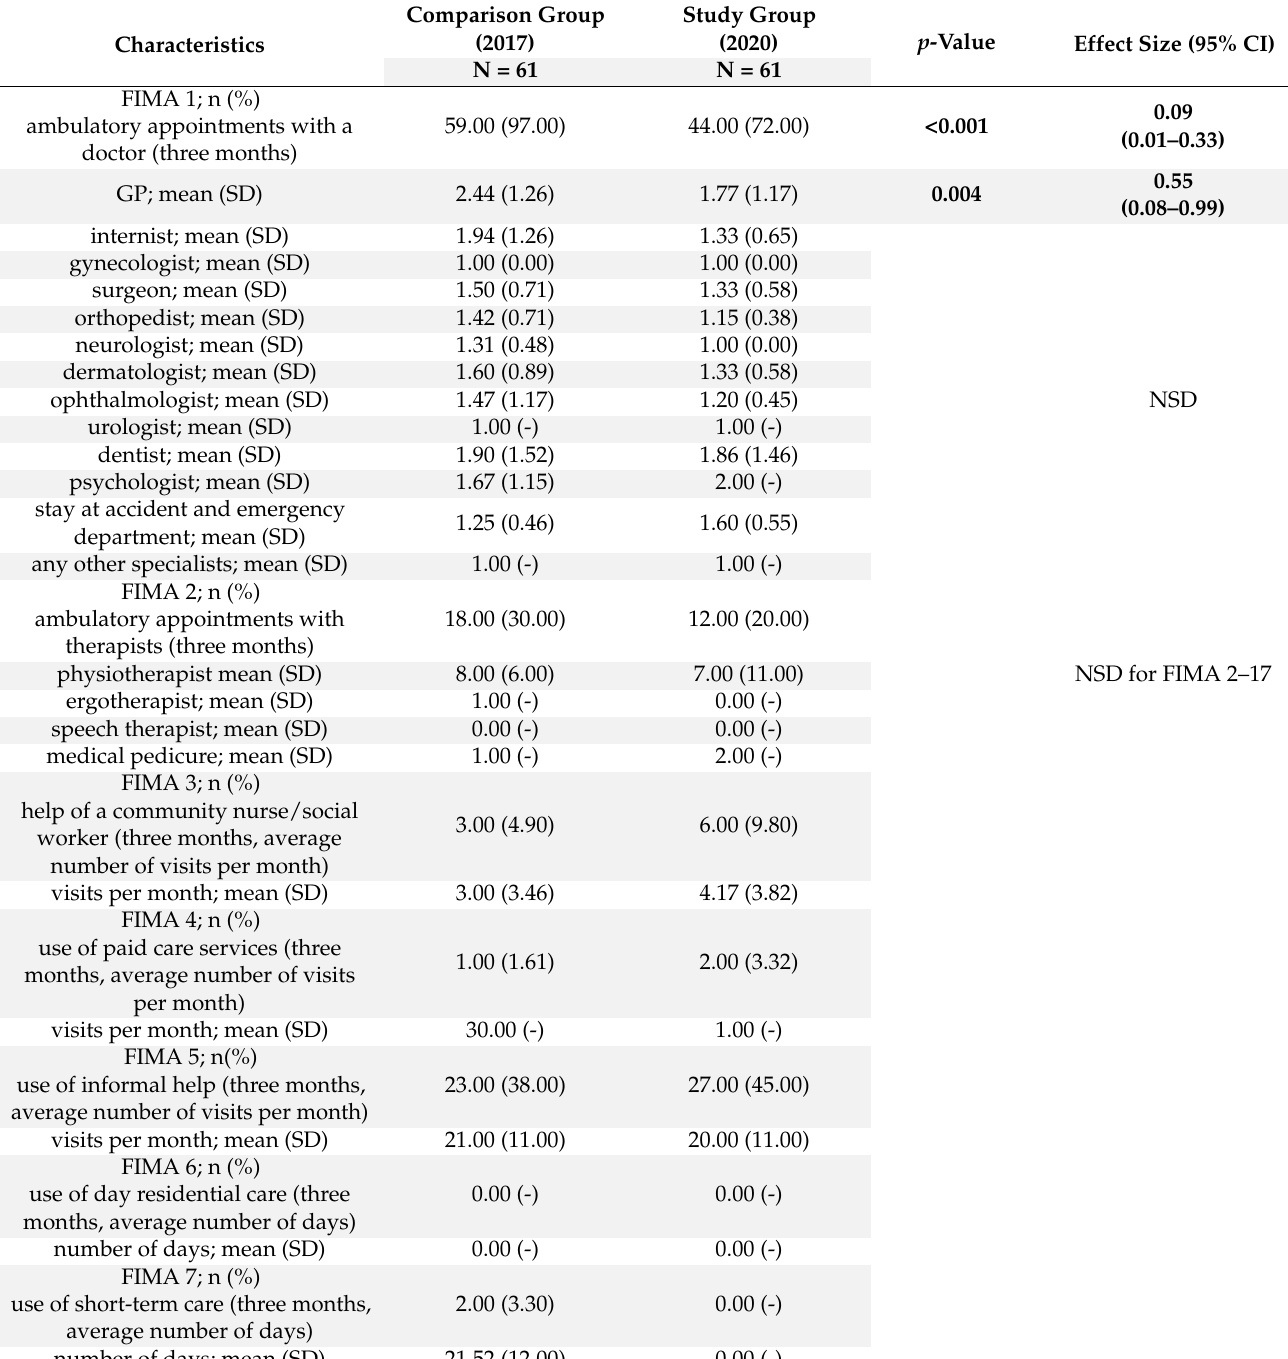
Table 3. Detailed FIMA questionnaire results for both